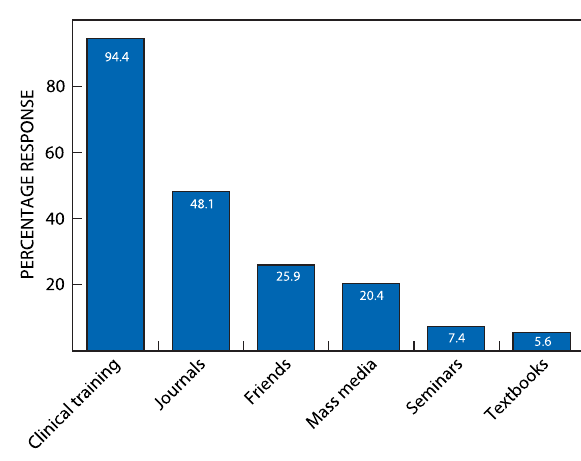
Figure 1: Sources of information about